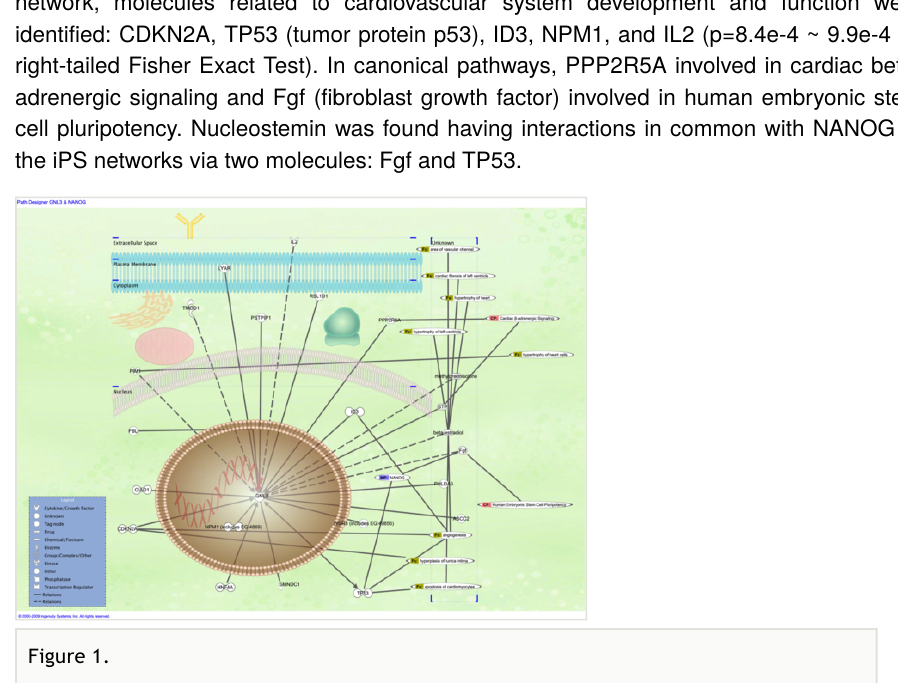
Nucleostemin (GNL3) and iPS (SOX2-OCT4-NANOG) subcellular interaction